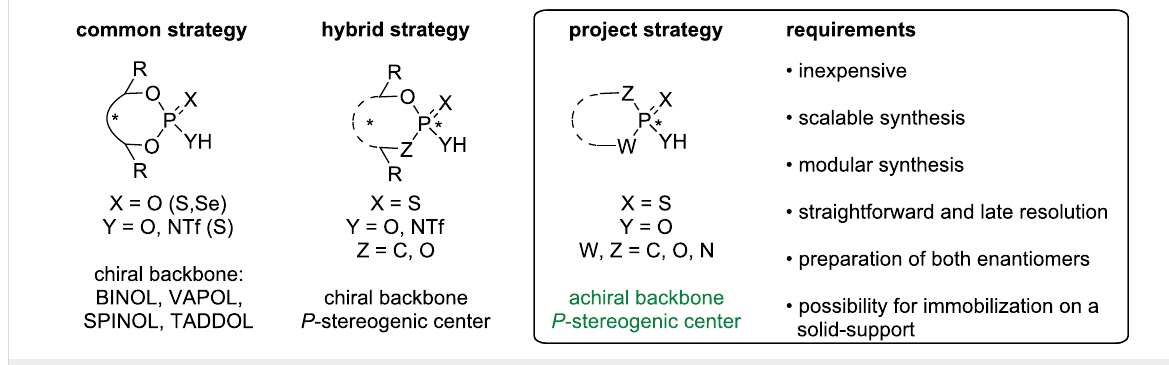
Figure 2: Project strategy and requirements for C 1 -symmetrical